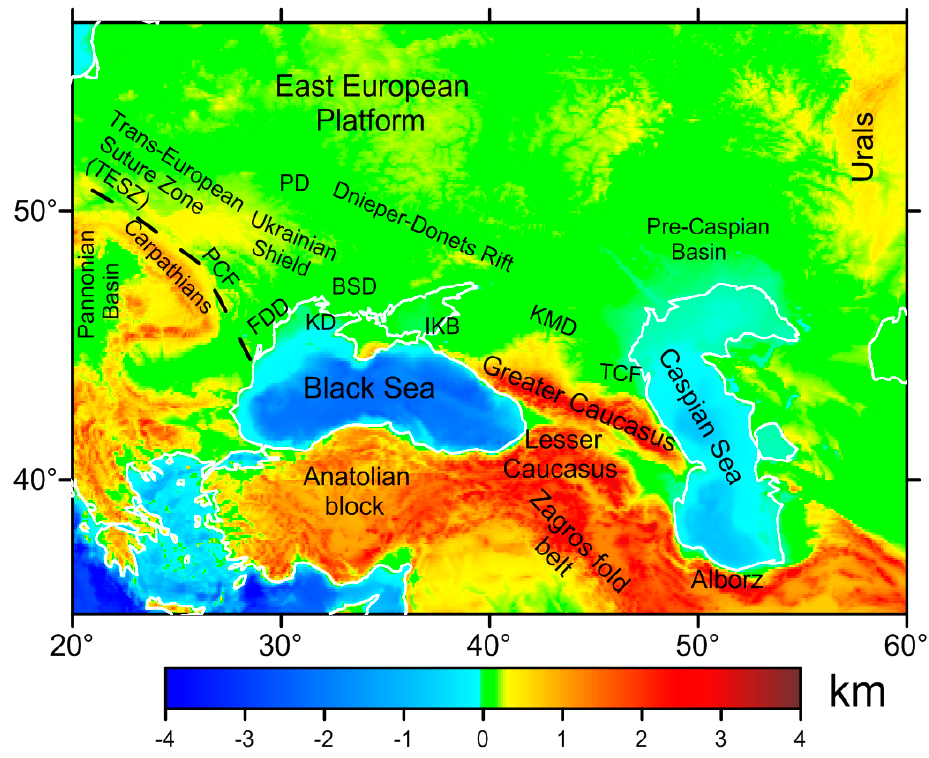
Figure 1. Study area (topography/bathymetry). Here and on all the subsequent maps the following abbreviations are used for the following sedimentary basins: PD—Pripyat depression basin, KMD –Kuma-Manych depression, KD—Karkinit depression, IKB—Indolo-Kuban basin, TCF—Terek–Caspian Foredeep, BSD—Black Sea Depression (lowland), FDB—Fore–Dobrogea depression, PCF—Pre-Carpathians foredeep.